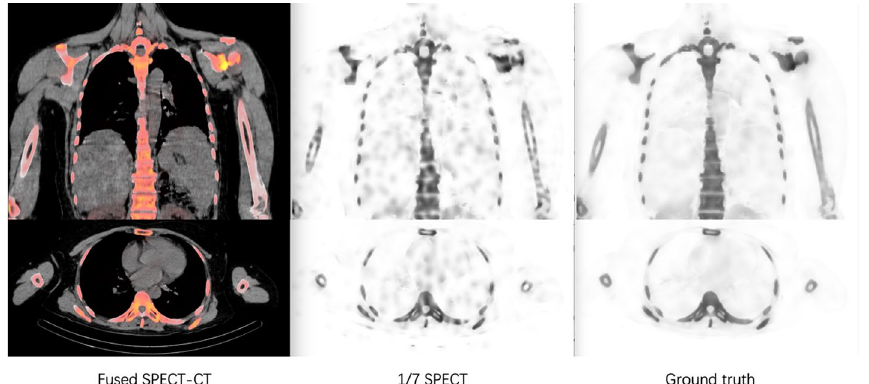
Fig. 1 One example of training dataset. The left images are coronal and axial views of fused SPECT and CT images. The middle images are coronal and axial views of 1/7 SPECT. The right images are coronal and axial views of the standard